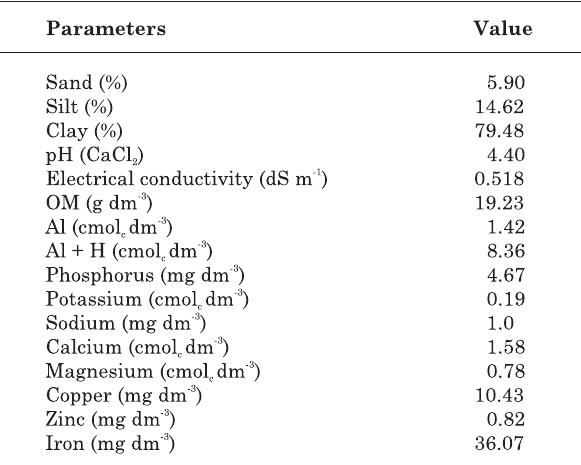
Table 1. Chemical and particle-size distribution analysis of soil of the experimental area